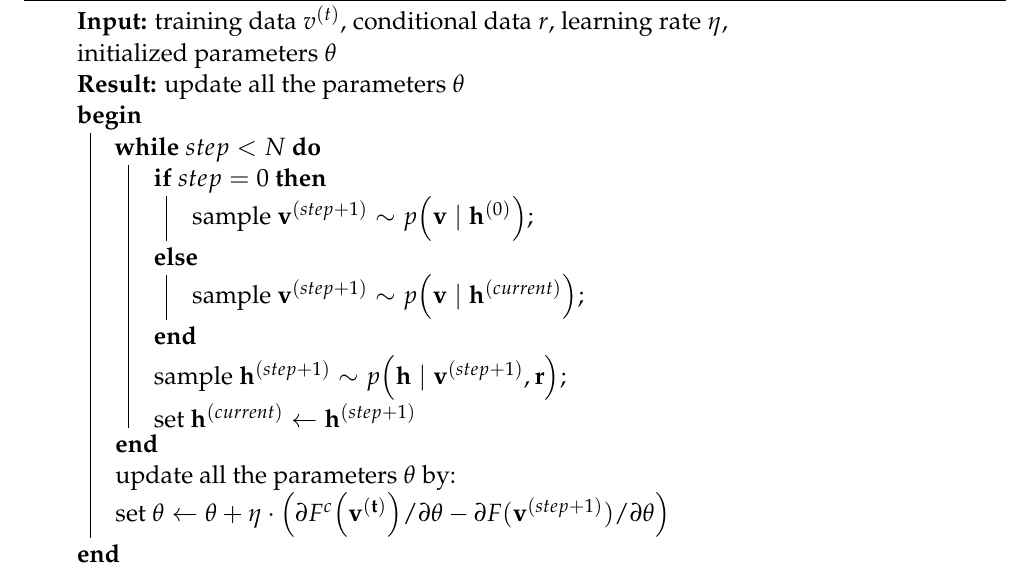
Algorithm 3: CD in M-CRBMs with free